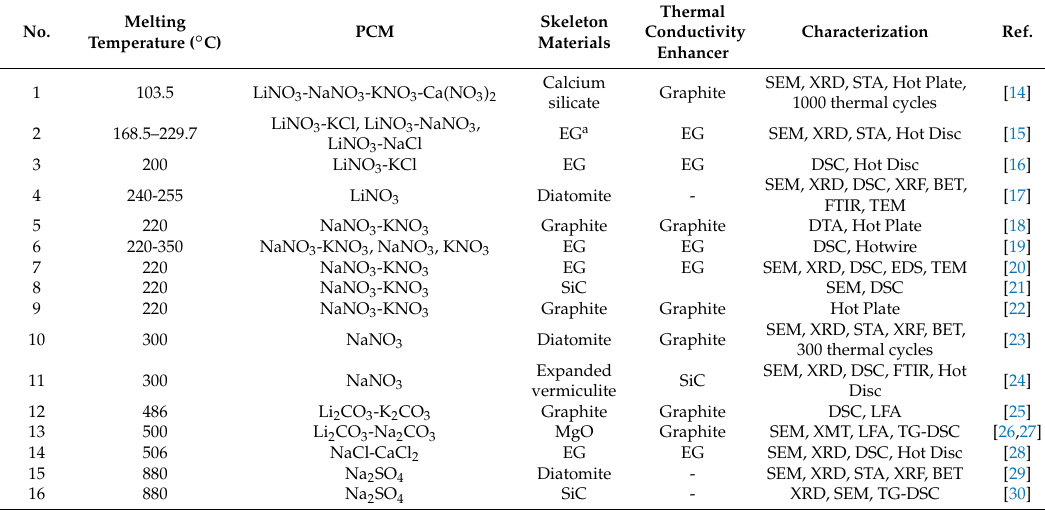
Table 1. Overview of salt-based form-stable composite phase change materials